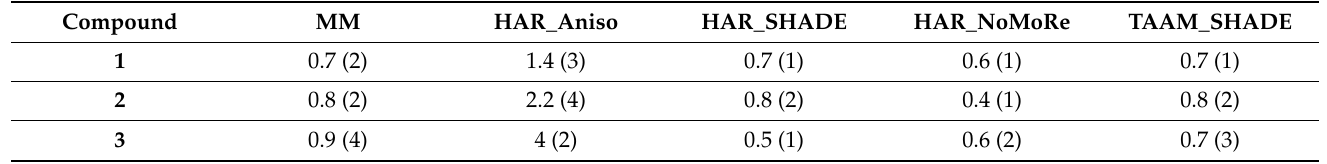
Table 3. Mean similarity index ( S ) with standard error of the mean for hydrogen atom ADPs of 1 , 2 , and 3 in comparison to the neutron results for MM, HAR_aniso, HAR_SHADE, HAR_NoMoRe, or TAAM_SHADE refinements.